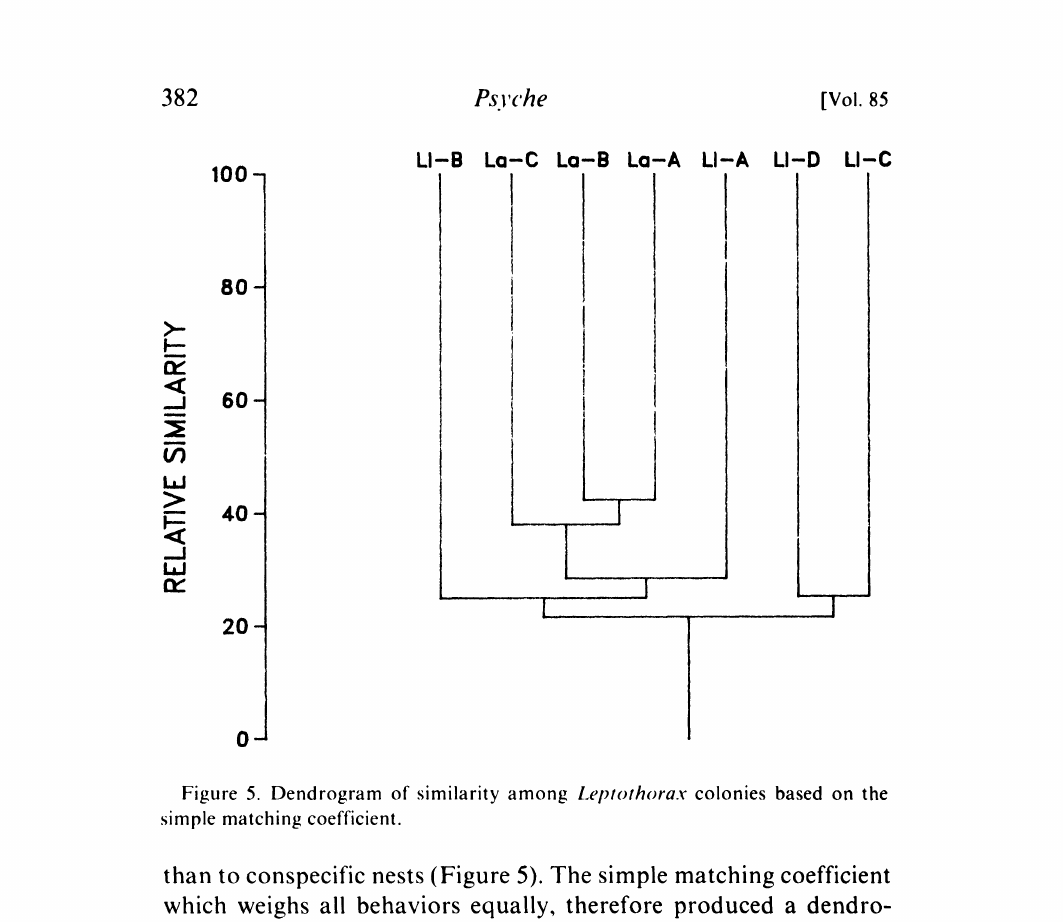
Figure 5. Dendrogram of similarity among l, eptothora.v colonies based on the simple matching